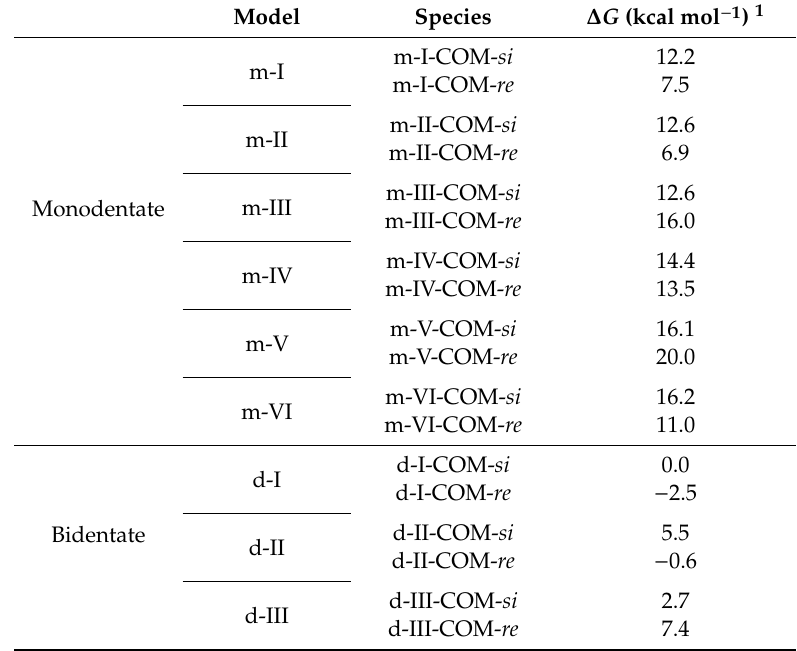
( b ) Scheme 3. Nine possible hexacoordinated Ti(IV)-complexes formed by coordinating olefin to Ti(IV) ion in a ( a ) bidentate and ( b ) monodentate fashion. Table 1. Relative Gibbs free energy for the formation of hexacoordinated Table 1. Relative Gibbs free energy for the formation of hexacoordinated Ti(IV)-complexes.